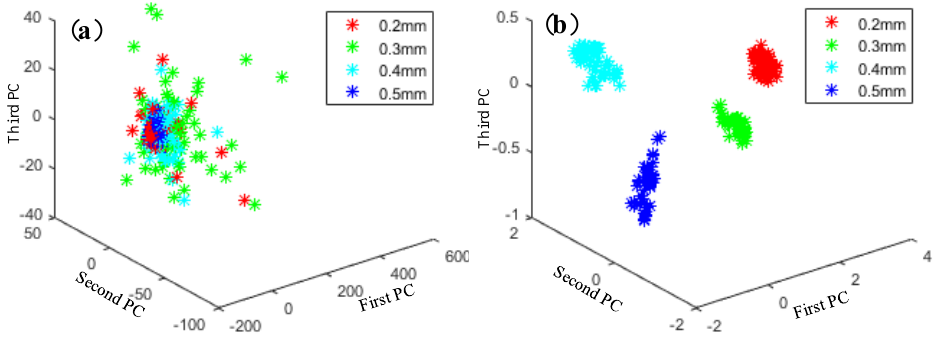
Figure 15. Feature visualization of various inner fault degrees: ( a ) raw data features and ( b ) proposed method.